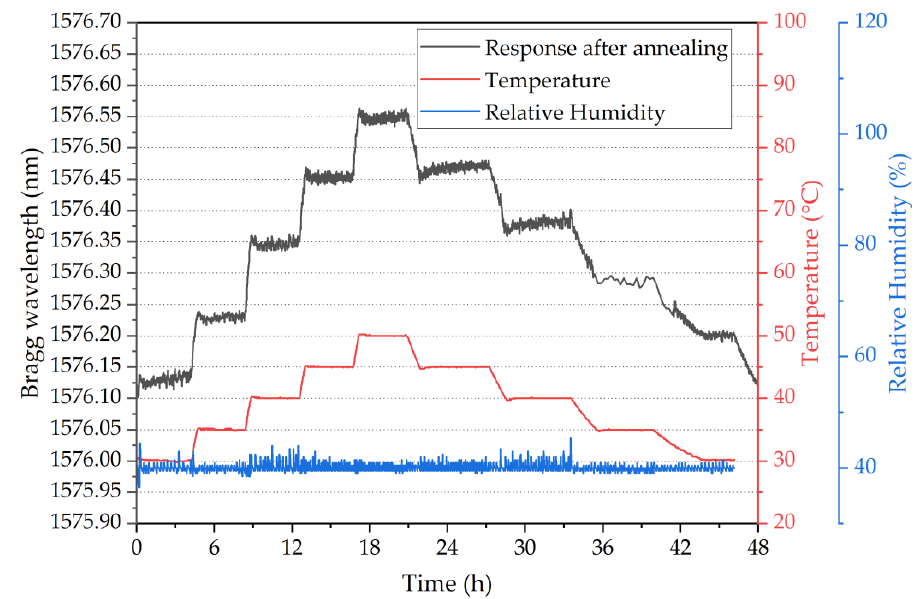
Figure 10. Temperature response of POFBG 4 after thermal annealing treatment.